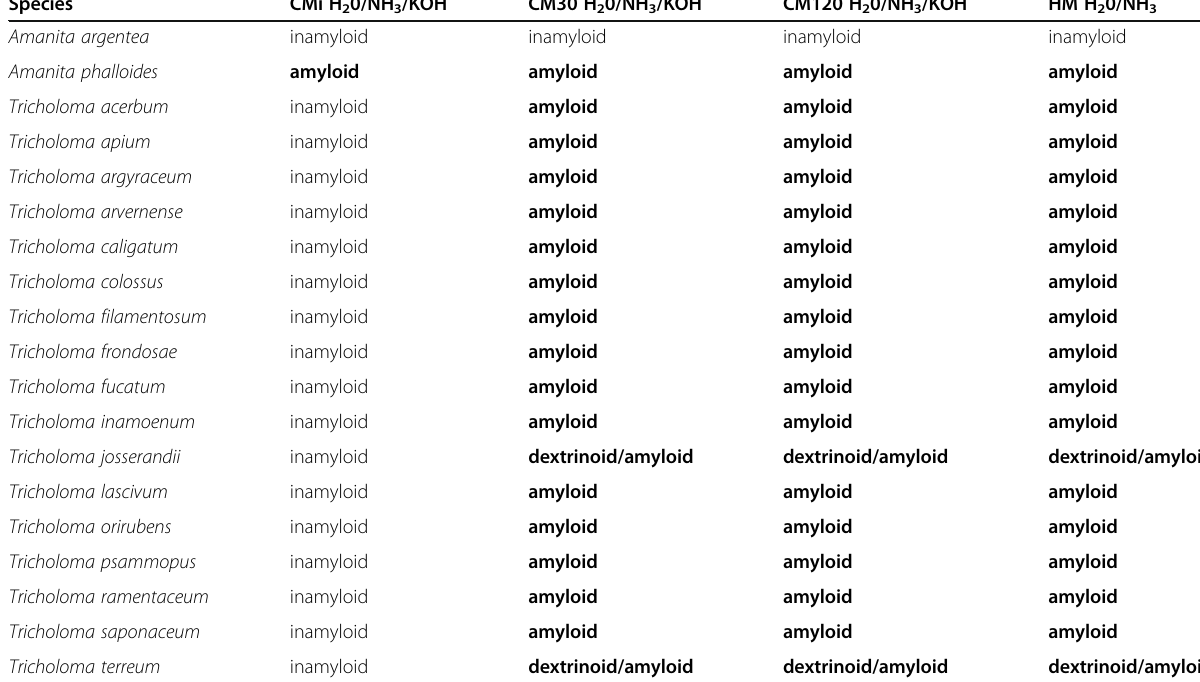
Table 1 Spore reaction in Melzer ’ s depending on the method used